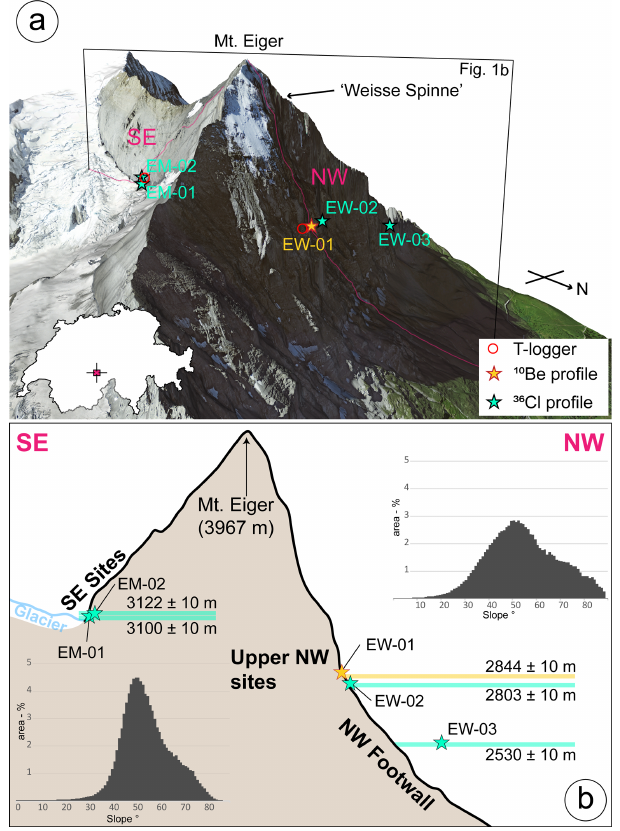
Figure 1. The Eiger in the Central Swiss Alps (insert) is character- ized by steep SE and NW rockwalls (a) ; sites for denudation rate es- timations with cosmogenic nuclides and temperature loggers from Gruber et al. (2004b) are indicated. (b) Schematic section along trace highlighted in panel (a) ; cosmogenic sampling sites ( 36 Cl sites from Mair et al., 2019) are projected into the section, and the eleva- tion of sample sites is also indicated. The area used for slope angle distribution is indicated in Fig.